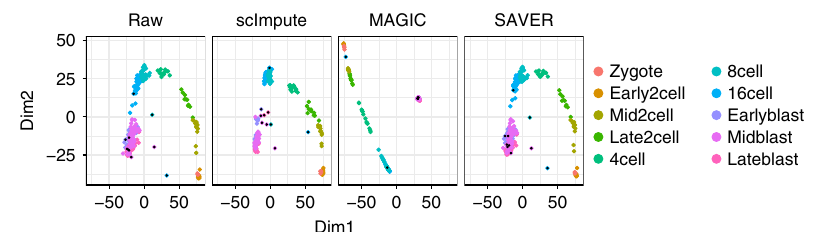
Fig. 5 scImpute improves cell subpopulation clustering in the mouse embryonic cells. The scatter plots show the fi rst two PCs obtained from the raw and imputed data of mouse embryonic cells. The black dots mark the outlier cells detected by scImpute